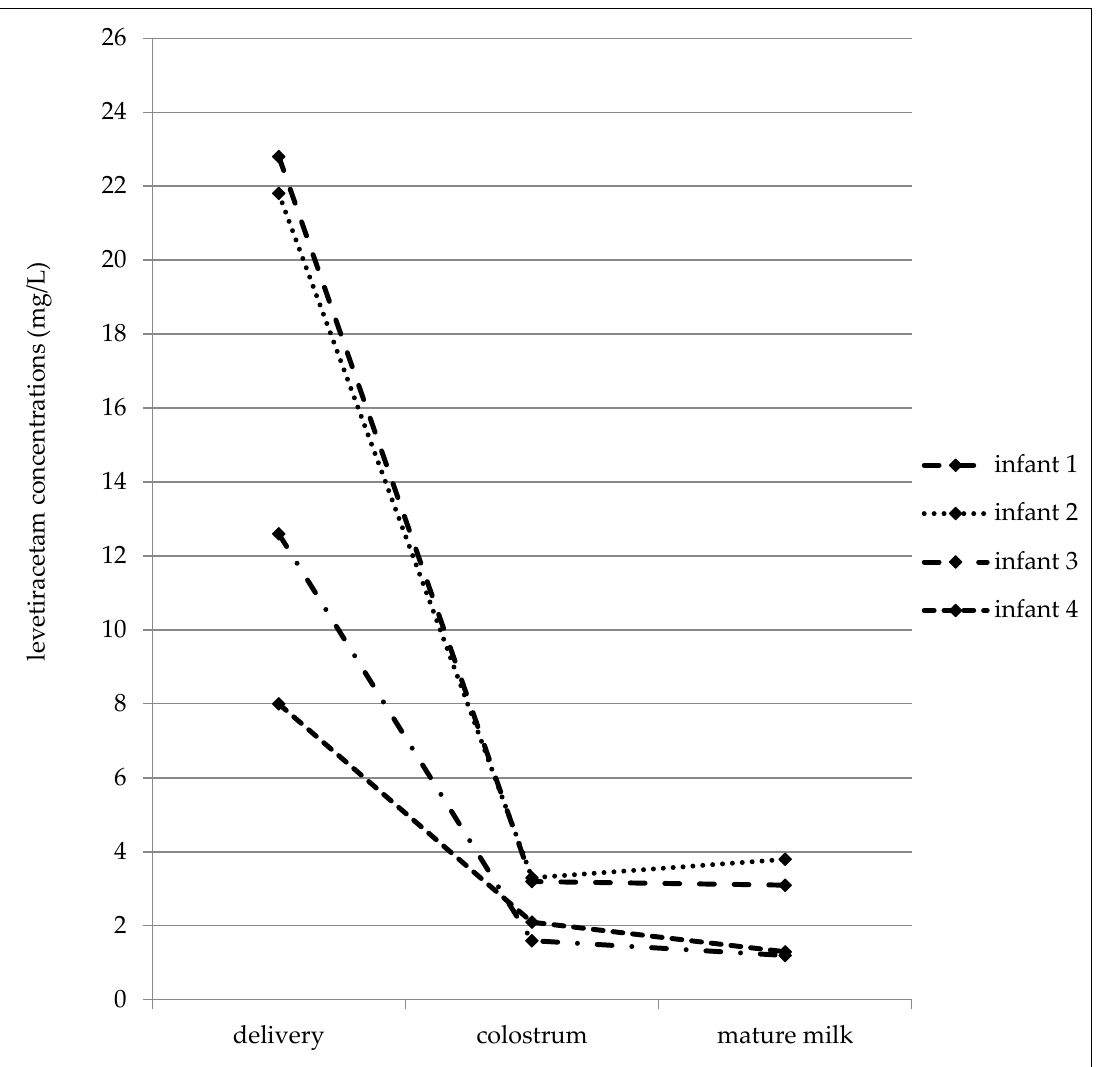
Figure 3. Levetiracetam serum concentrations obtained from four breastfed infants in all three time points (delivery–colostrum–mature milk). Table 4. Dosage, maternal apparent oral clearance (Cl), maternal (M) serum, milk (Mi), and infant (I) serum levetiracetam concentrations and their ratio 7–31 days after delivery and 2–31 days after delivery altogether.